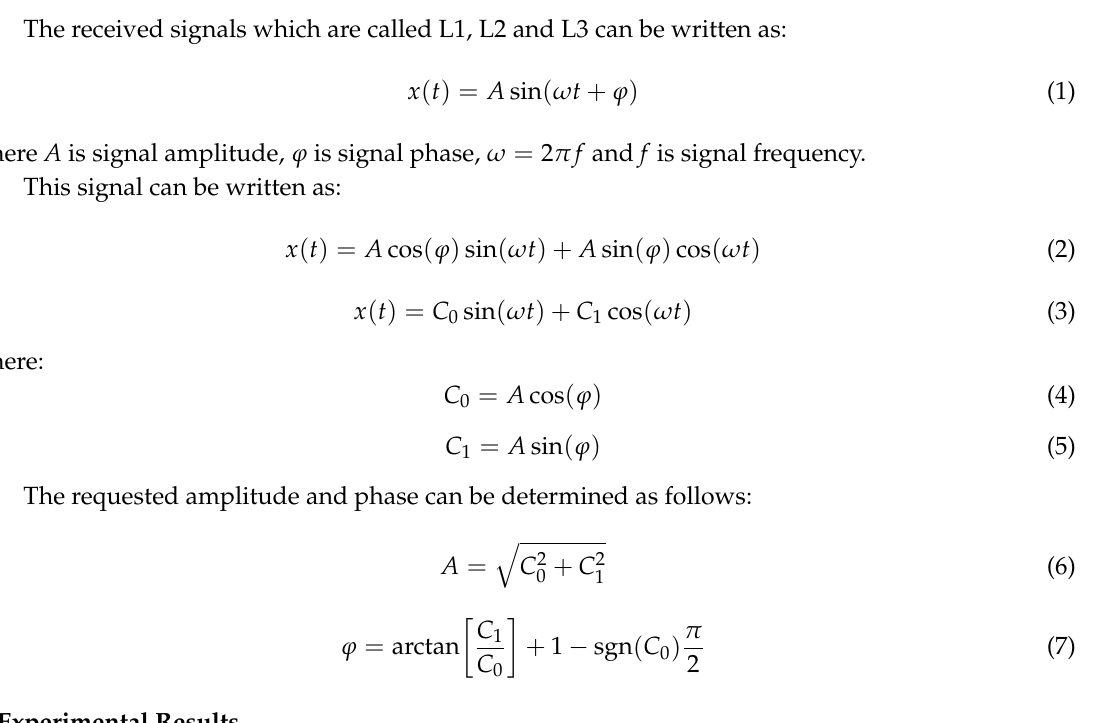
Figure 2. Principle structure diagram of ultrasonic sensor.